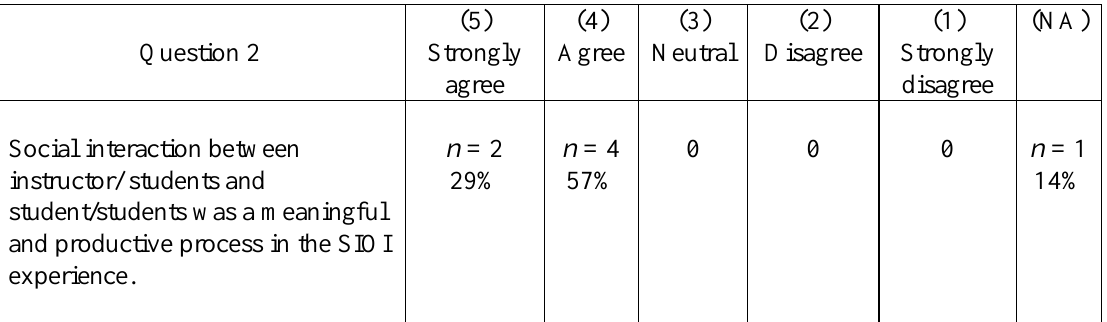
Six respondents (86%) agreed or strongly agreed social interaction between instructor/students